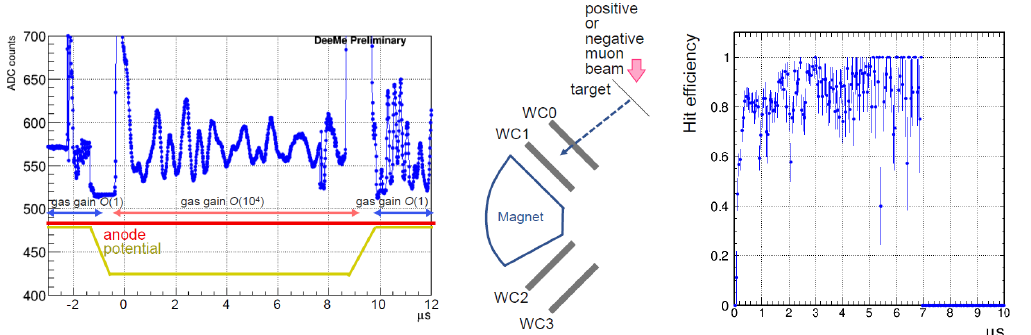
Figure 6: Output waveform of a cath- ode strip signal amplified through an amplifier.